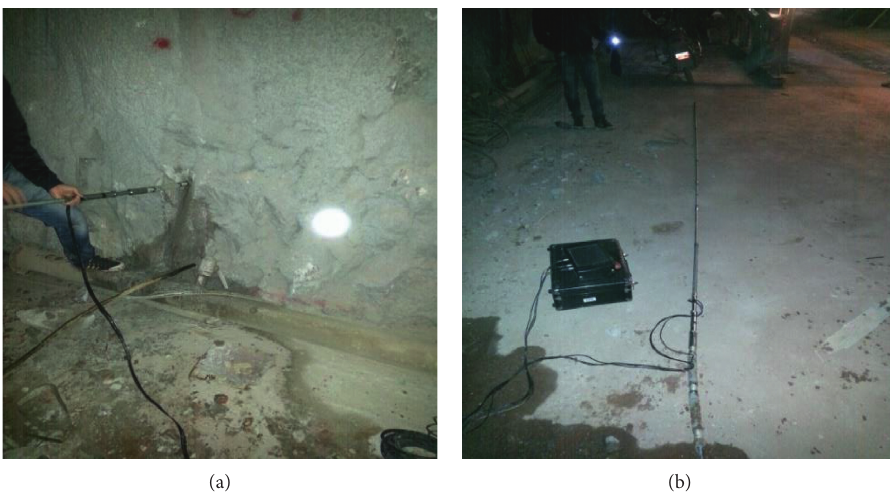
Figure 4: (a) Test hole. (b) Ultrasonic wave apparatus in field